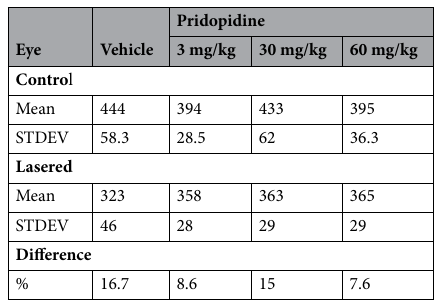
Table 3. Number of optic nerve axons in contralateral control eyes and in the laser-treated eyes after 125/55 inclusion criterion was applied.